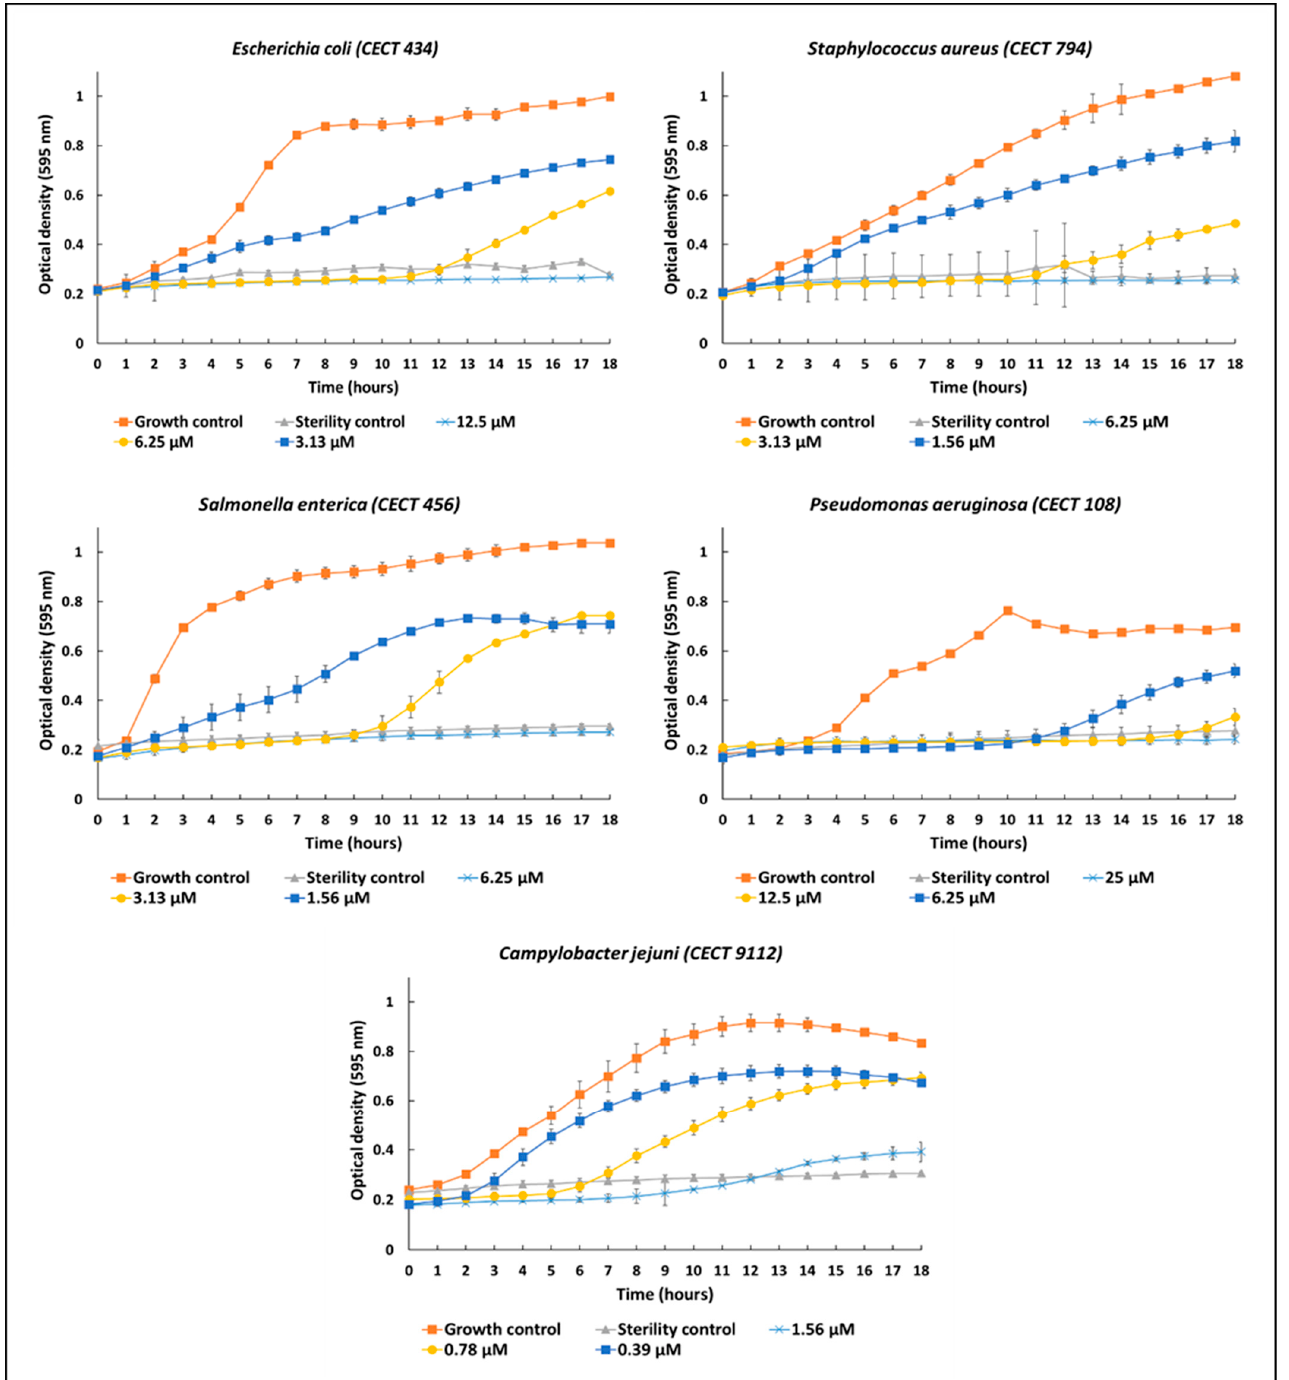
Figure 7. Kinetic studies of five microorganisms against different concentrations above and below the MIC of the synthetic peptide To-KL37 during 18 h of in vitro culture.